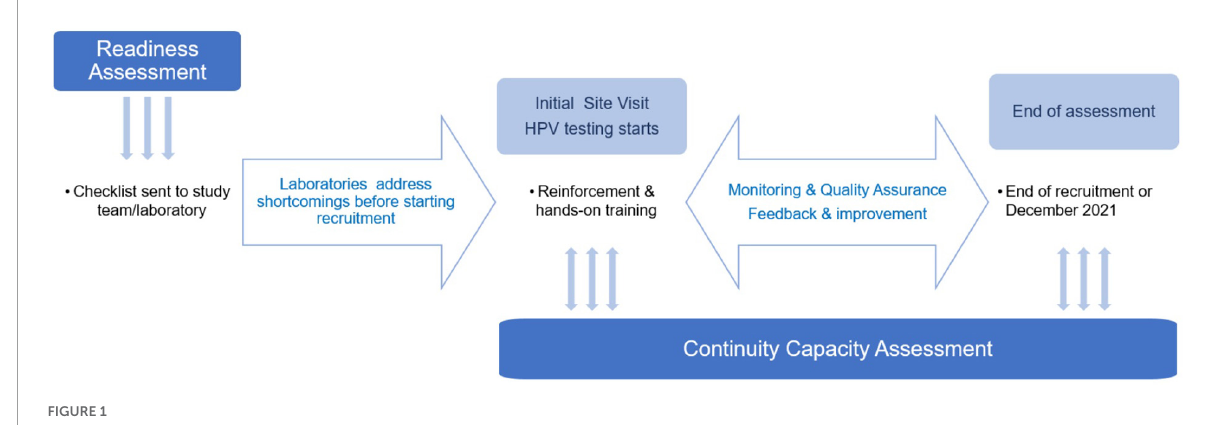
FIGURE1 Steps followed in ESTAMPA for HPV testing